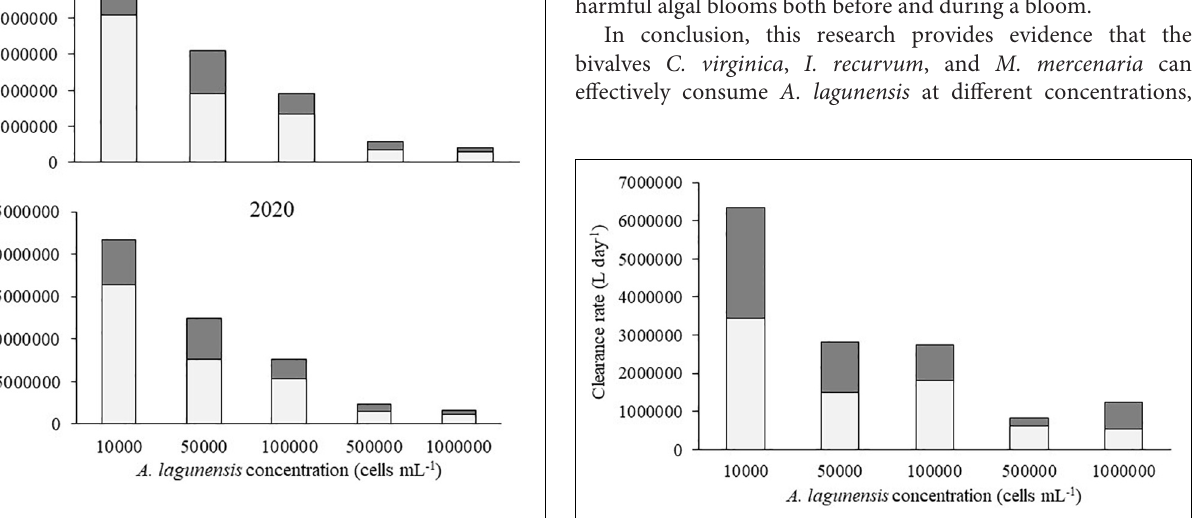
FIGURE 7 | Graph plotting Mercenaria mercenaria clearance rate minimum (light column) and maximum (dark column) values estimated at each brown tide concentration for a population of 2M 1-inch